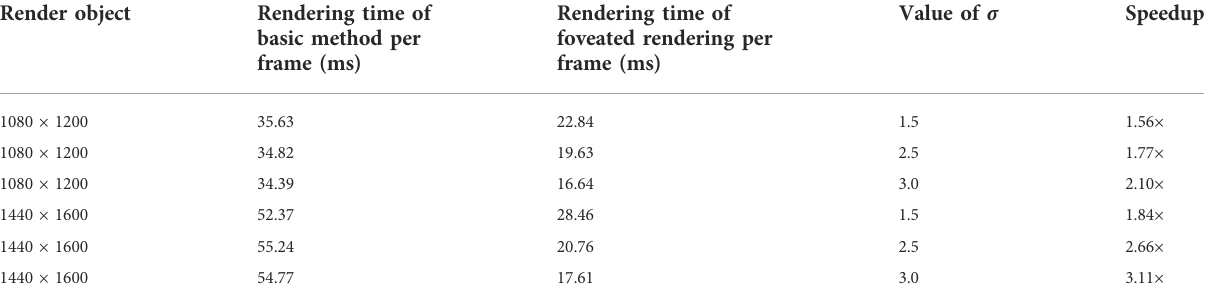
TABLE 2 The speed improvements for foveated